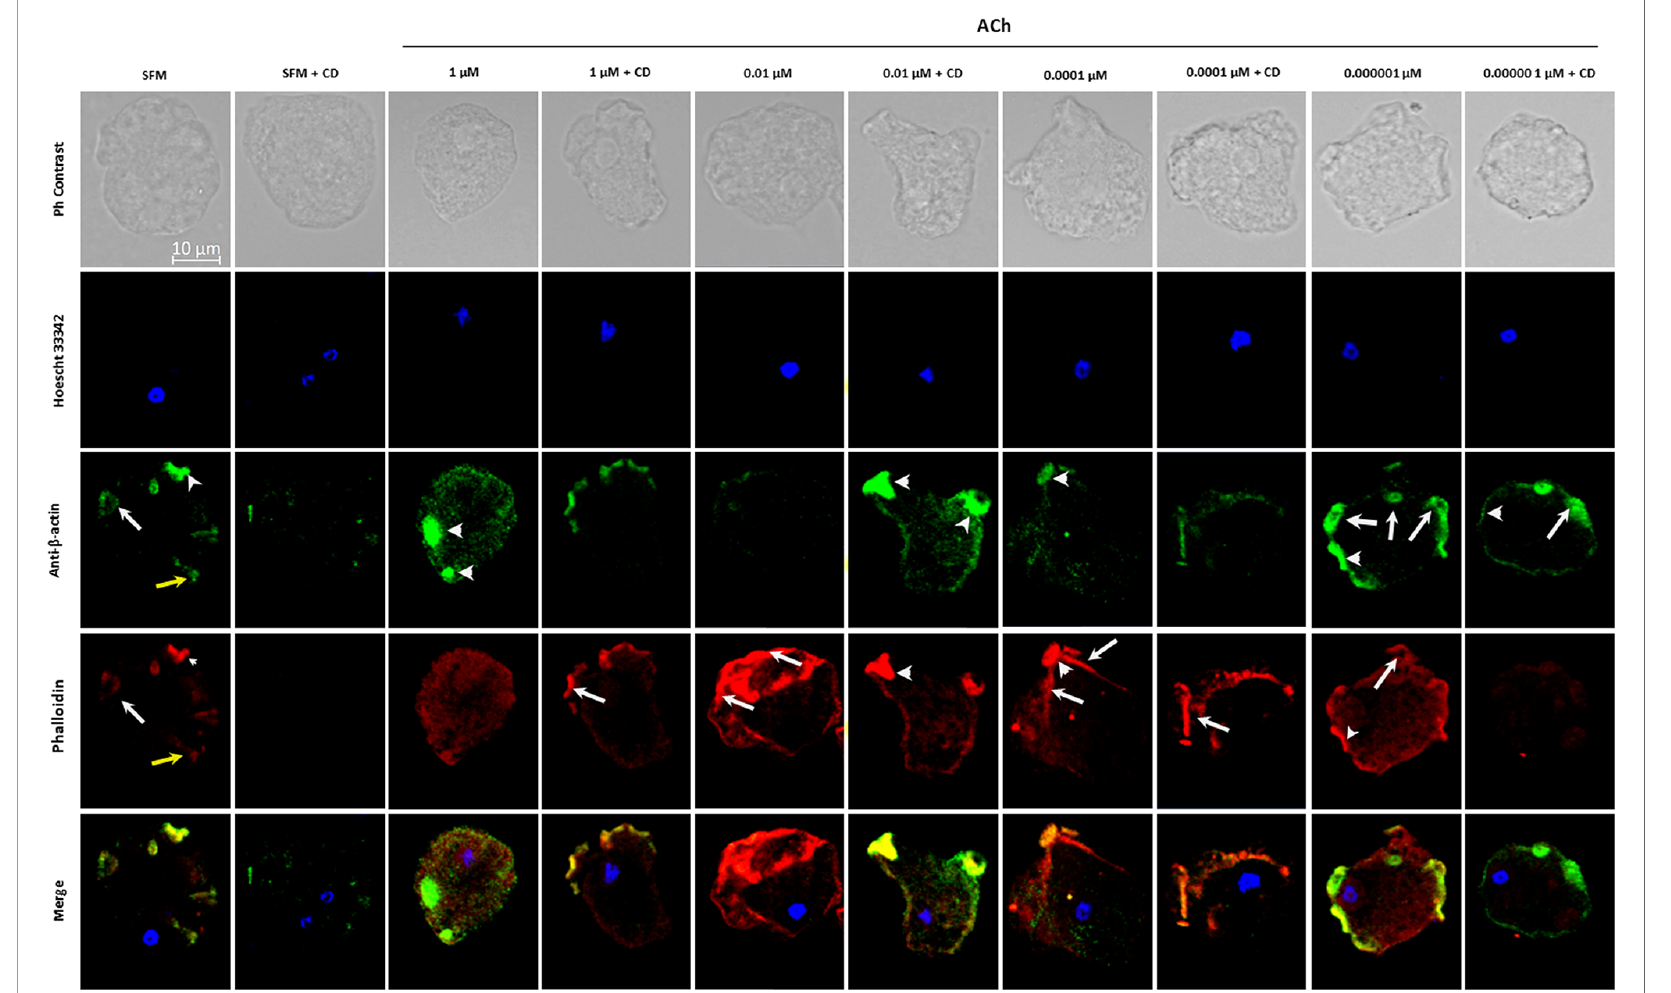
FIGURE 5 | Detection and location of G-actin and F-actin in trophozoites treated with acetylcholine. G-actin was determined by using anti- b -actin, followed by antibody Alexa Fluor 488 conjugated goat anti rabbit- IgG (1:1000) (green); F-actin was determined with rhodamine-phalloidin (red); and nuclear DNA staining was done by Hoechst 33342 (blue). Cytochalasin D (CD) was used as a negative control. Representative images acquired by confocal microscopy at X63 show F-actin rich structures as macropinosomes (white arrows), adhesion plates (white arrow heads) and F-actin cytoplasmic dots (yellow